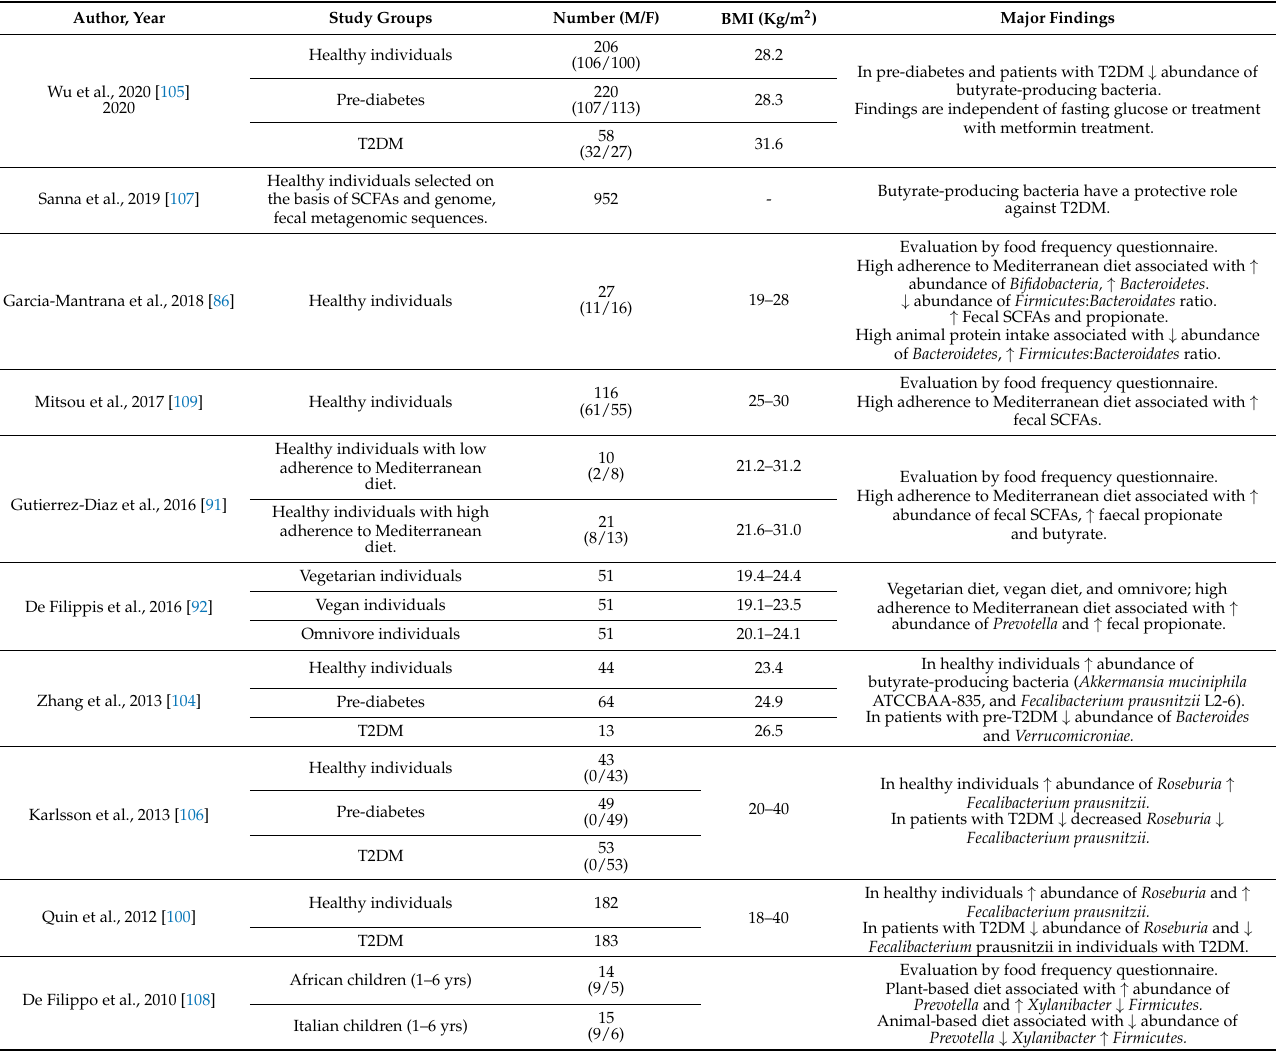
Table 5. Observational studies pointing to the role of SCFAs in the maintenance of glucose homeosta- sis, in pre-diabetes and